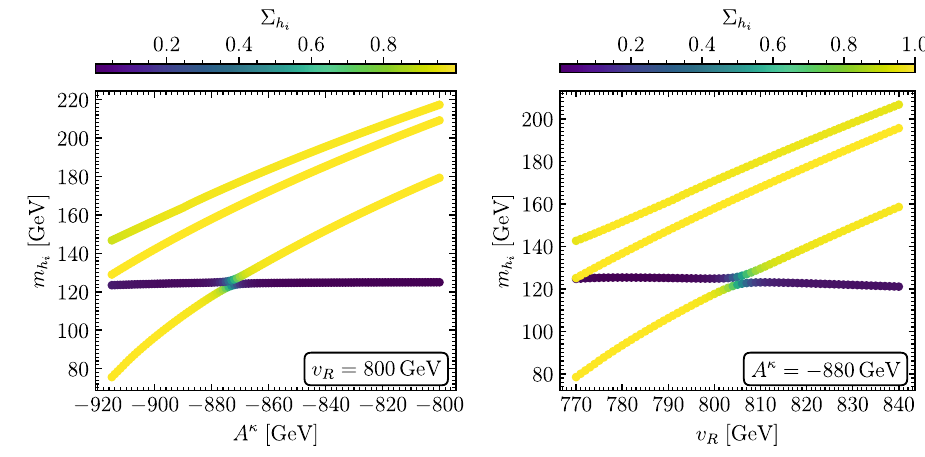
Fig. 1 Masses of the Higgs bosons that are in the vicinity of 125 GeV as function of A κ (left) and v R (right). All points pass the HiggsBounds test. All points except the ones with m The color coding indicates the gauge singlet component